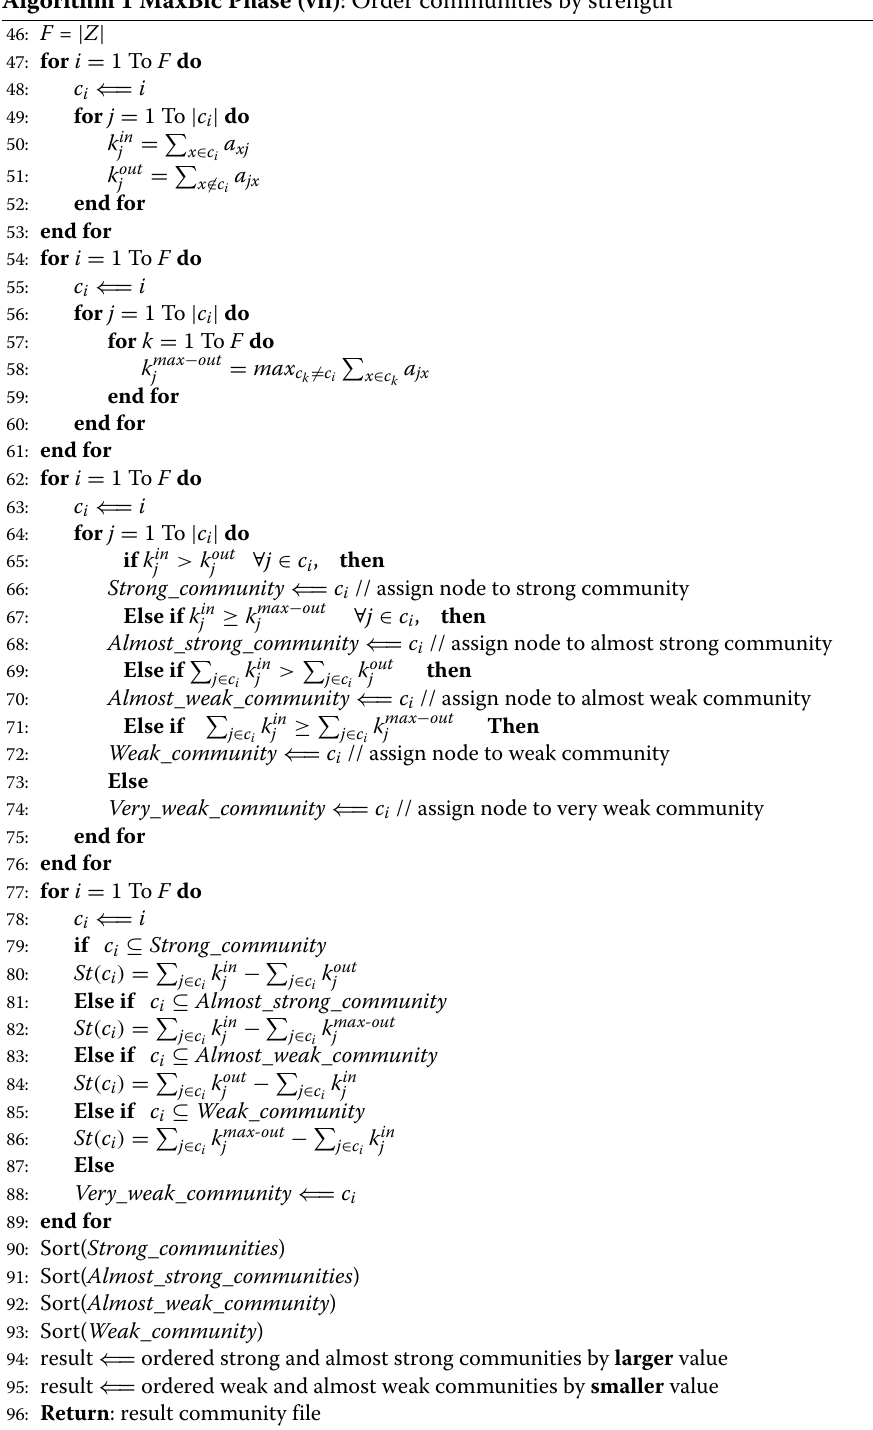
Algorithm 1 MaxBic Phase (vii) : Order communities by